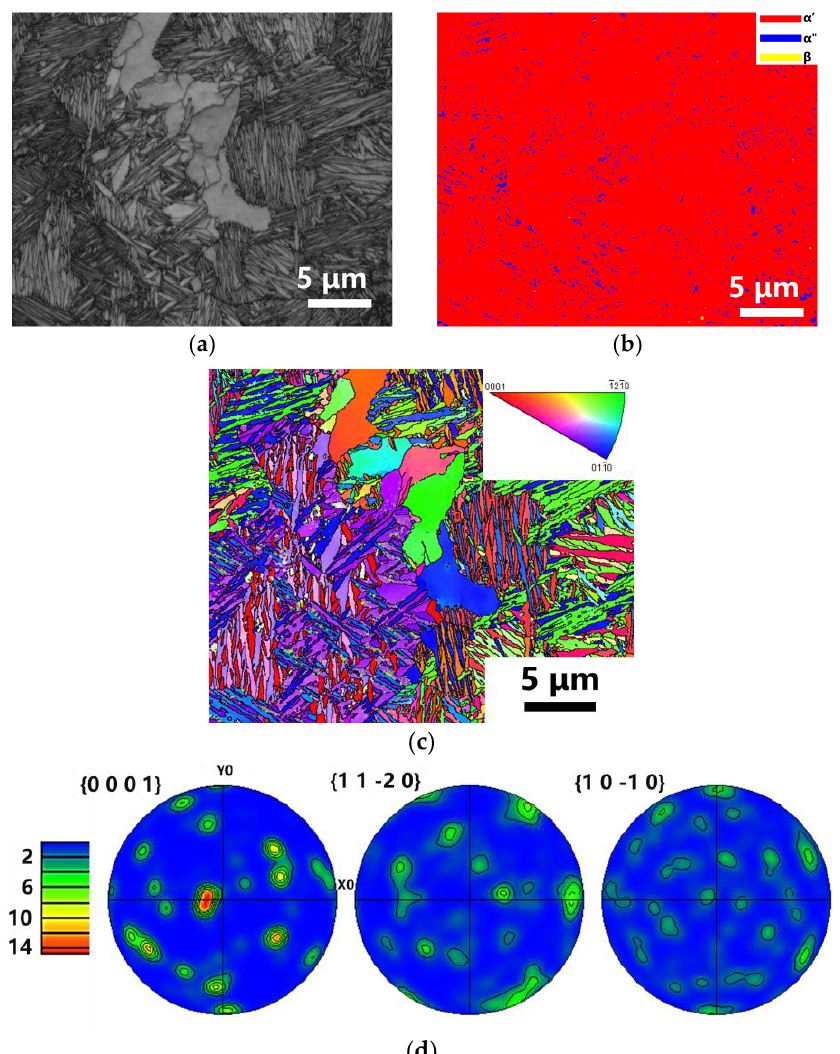
Figure 10. A series of images of EBSD results for sample S2 of LPBF Ti ‐ Ta. ( a )The position of the EBSD testing area, ( b )The phase distribution, ( c ) IPF maps and ( d ) pole figure of α′ martensite in sample S2 (v = 220 mm/s, E = 381 J/mm 3 ).